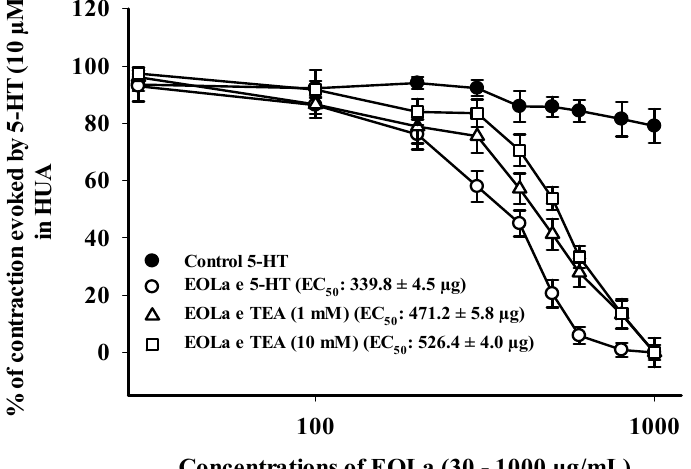
Figure 6. Relaxant effect of EOLa (30–1000 µ g/mL) and assessment of the participation of high conductance K + channels activated by Ca 2+ (BKCa) and voltage-operated K + channels (K v ) in HUA. “Log-normal” plot for EOLa effect on contractions evoked by 5-HT (10 µ M) in HUA rings preincubated in TEA (1 mM or 10 mM). Values are expressed as the mean ± SEM; n = 6 ( p < 0.05, one ‐ way ANOVA).